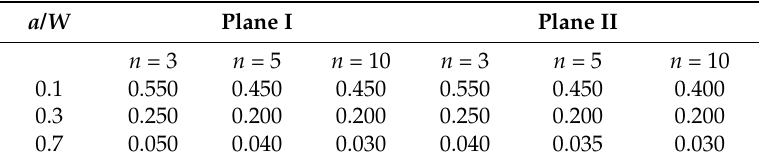
Table 4. Maximum predicting loads ( σ / σ 0 ) for 3D SECP under biaxial loading ( λ = 1.0), in plane I and II.